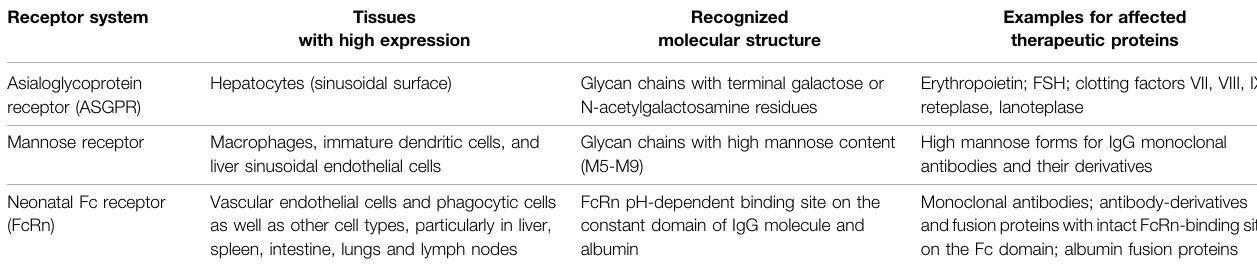
Recognized molecular structure